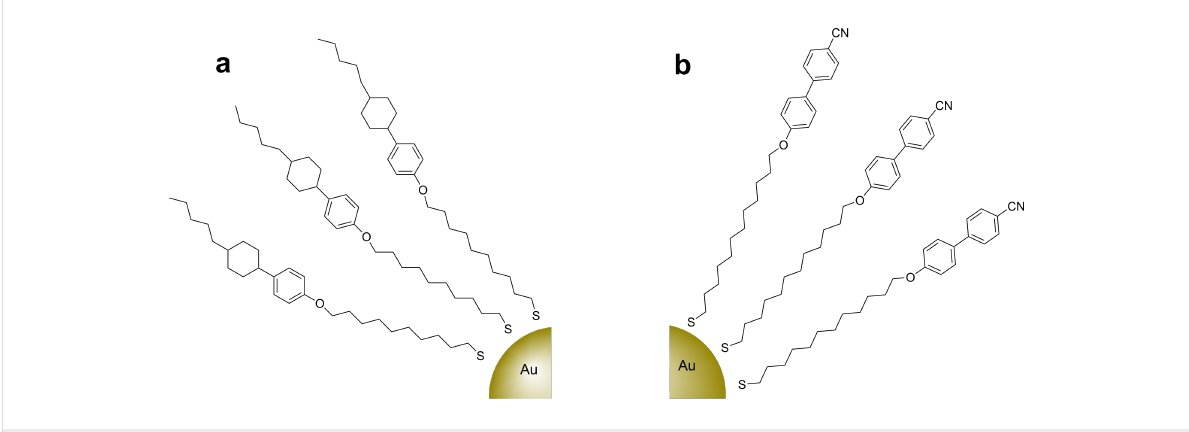
Figure 4: Schematic representation of pseudospherical Au NPs coated exclusively with mesogenic rodlike ligands (a) Au@5 and (b) Au@6 12 .